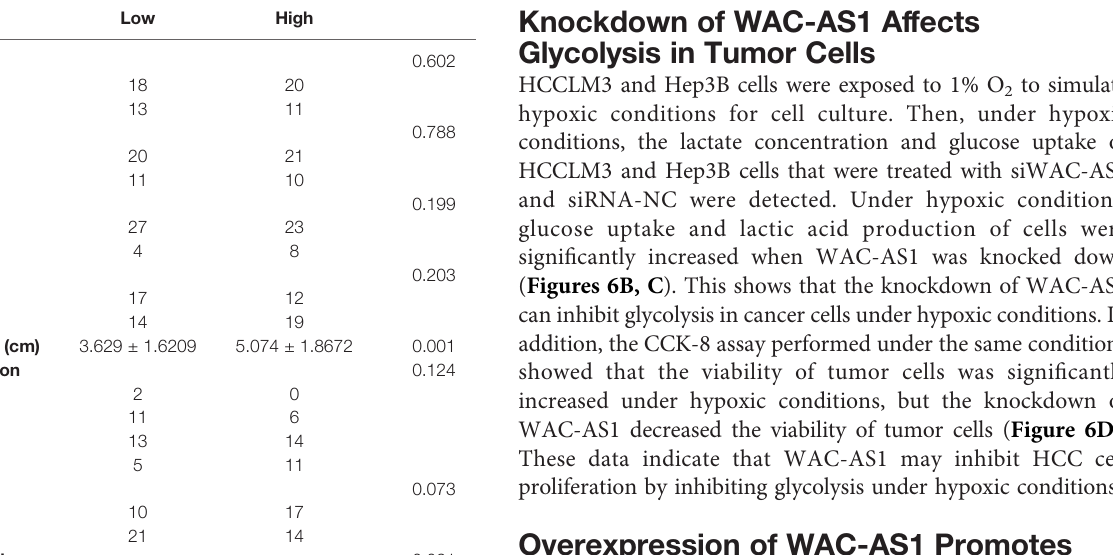
TABLE 1 | Correlation between WAC-AS1 expression and clinicopathologic characteristics of liver cancer patients. Characteristics